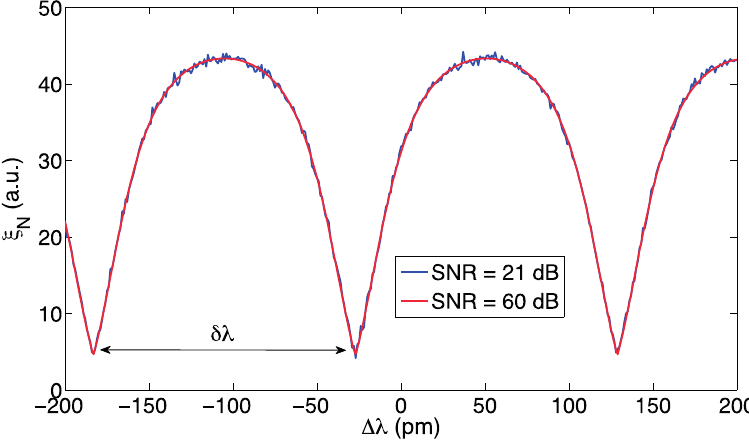
Figure 4. High-rank eigenvalue ξ N as a function of the FBG wavelength shift Δ λ